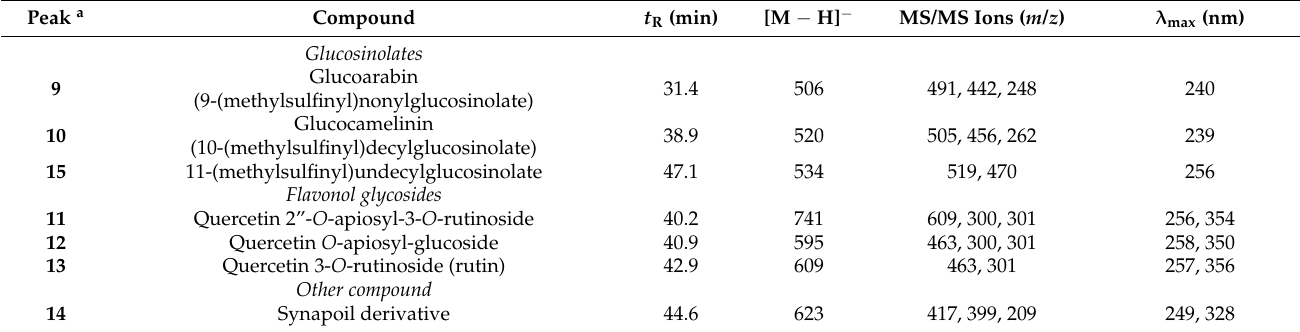
a Compound numbers correspond with peak numbers in Figure